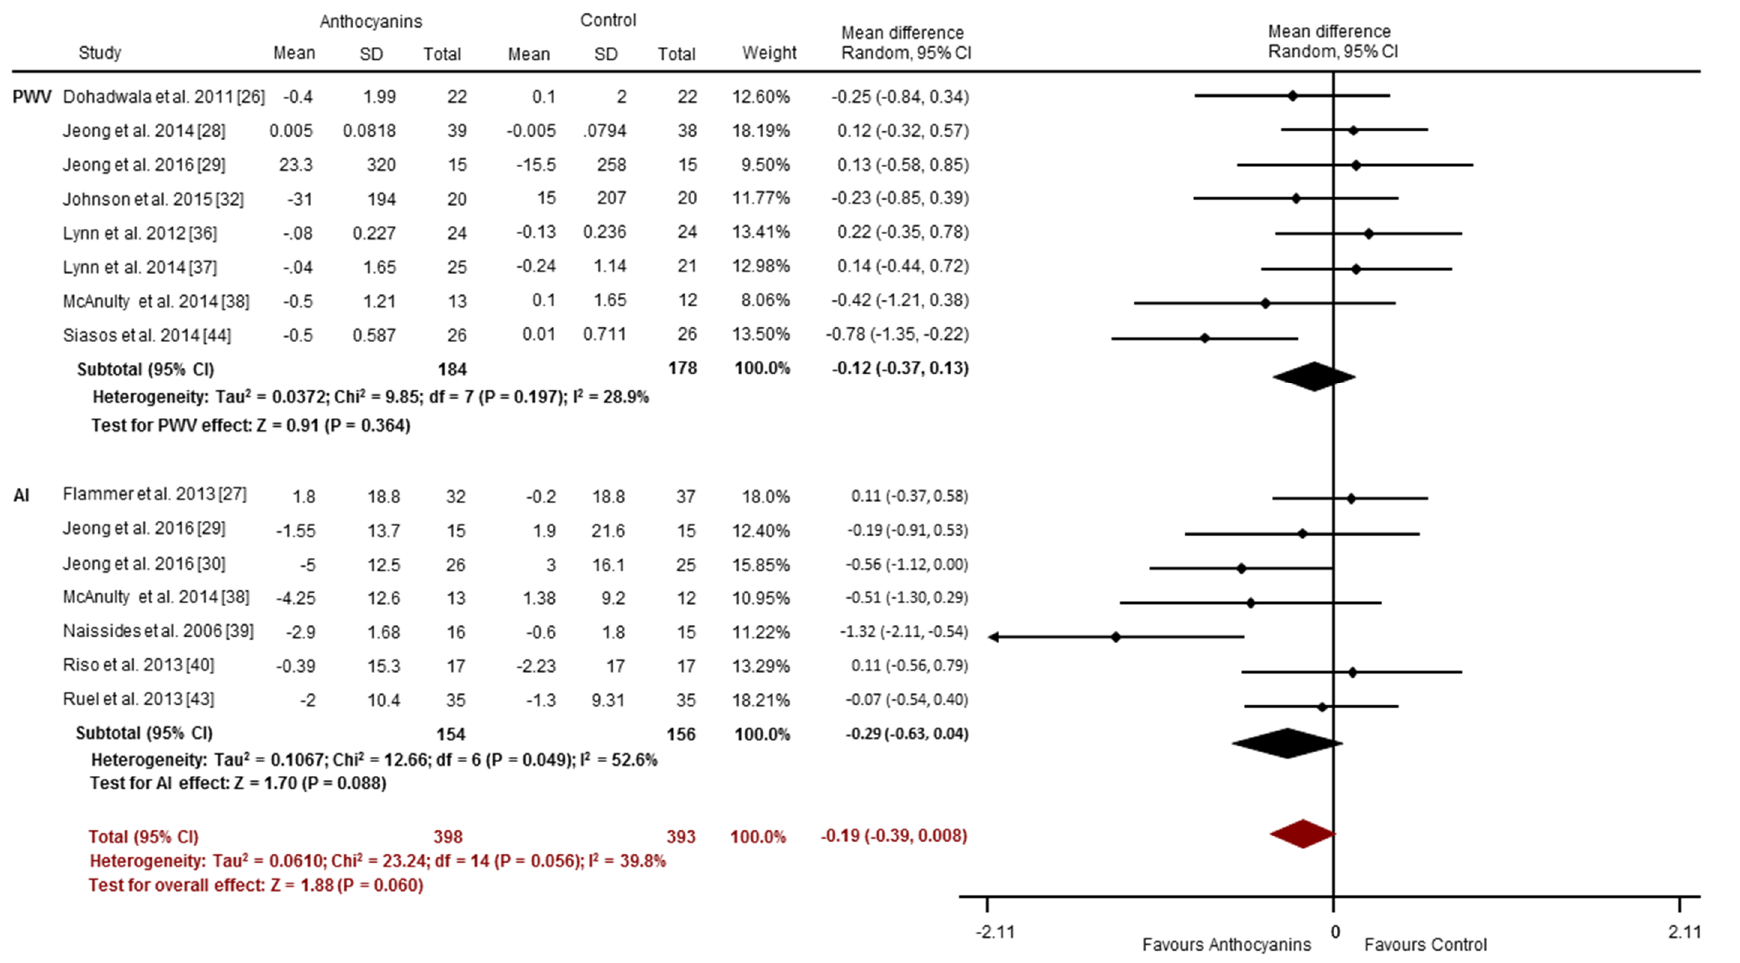
Figure 6. Chronic effects of anthocyanins relative to control for vascular stiffness (assessed via PWV and AI). The forest plot has one line representing each study in the meta ‐ analysis, plotted according to the mean difference (indicated by the black diamond in each line). The horizontal line joins the lower and upper limits of the 95% CI of these effects. The black diamond at the bottom of each graph represents the average effect size for PWV and AI studies. The red diamond represents the average effect size for all studies assessing vascular reactivity.